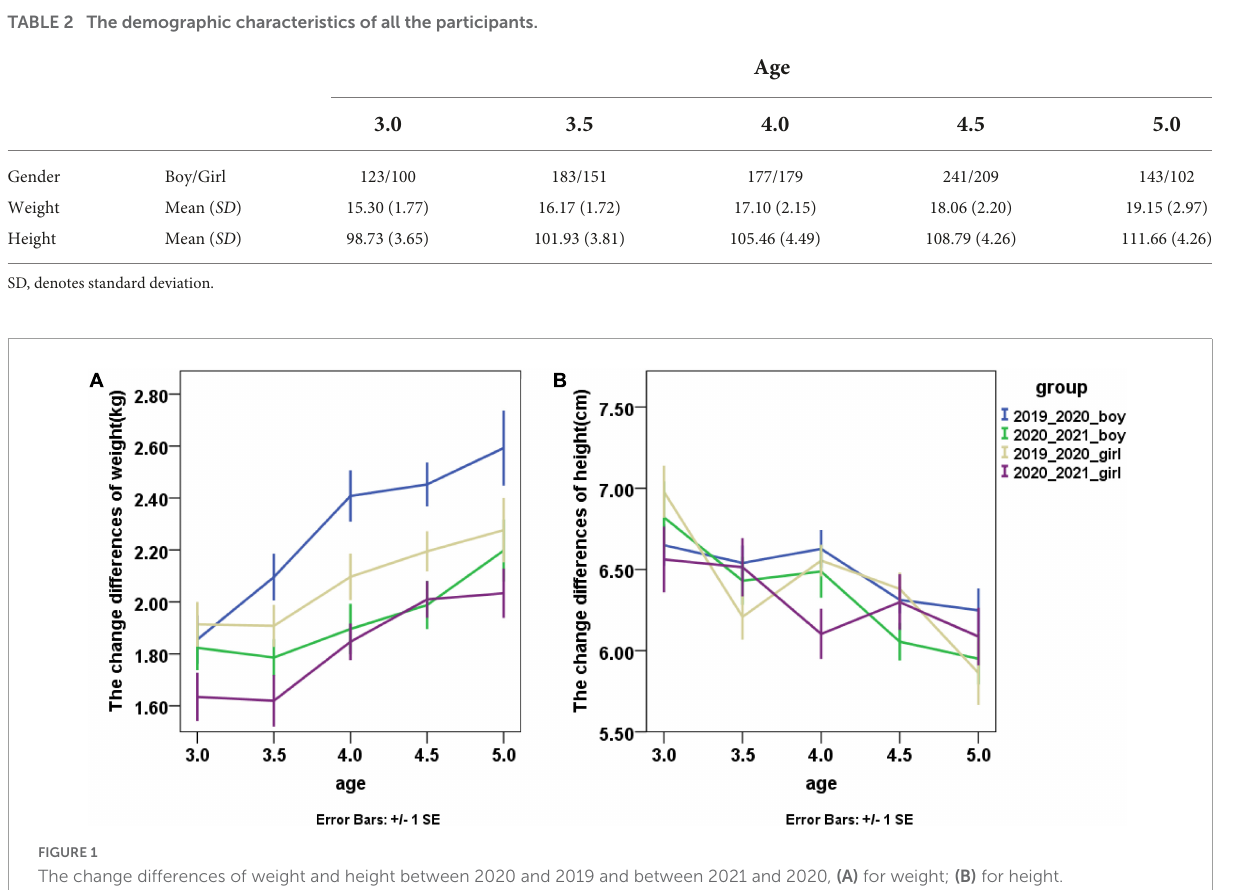
findings suggested that preschool children had larger growth rates in muscle strength of the upper limb during the COVID-19 school closure